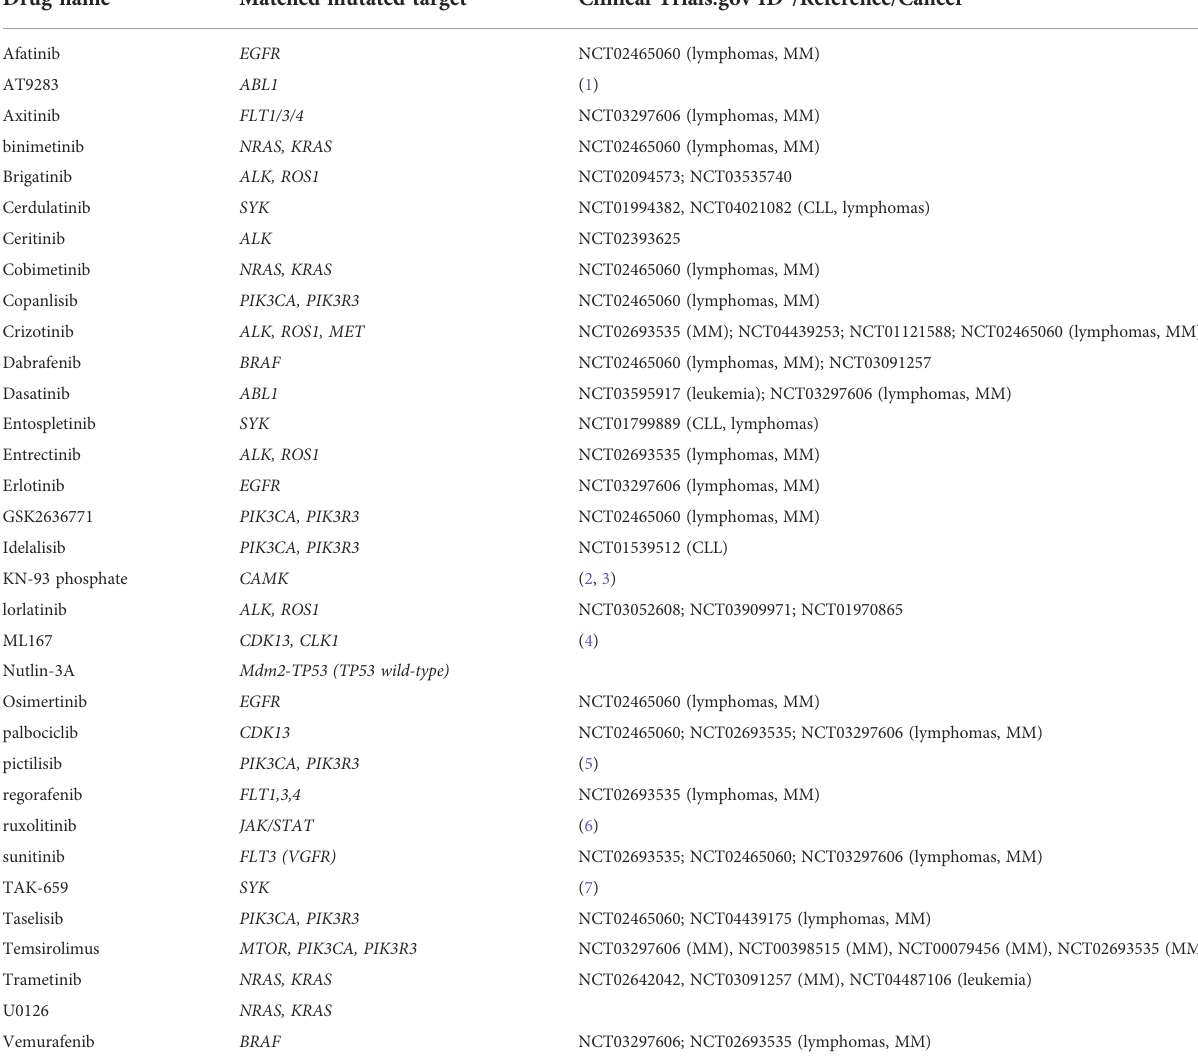
The table contains information about the drugs (n=33) selected in this study, including their target, clinical trial, and if the drug is being tested in MM or related B-cell